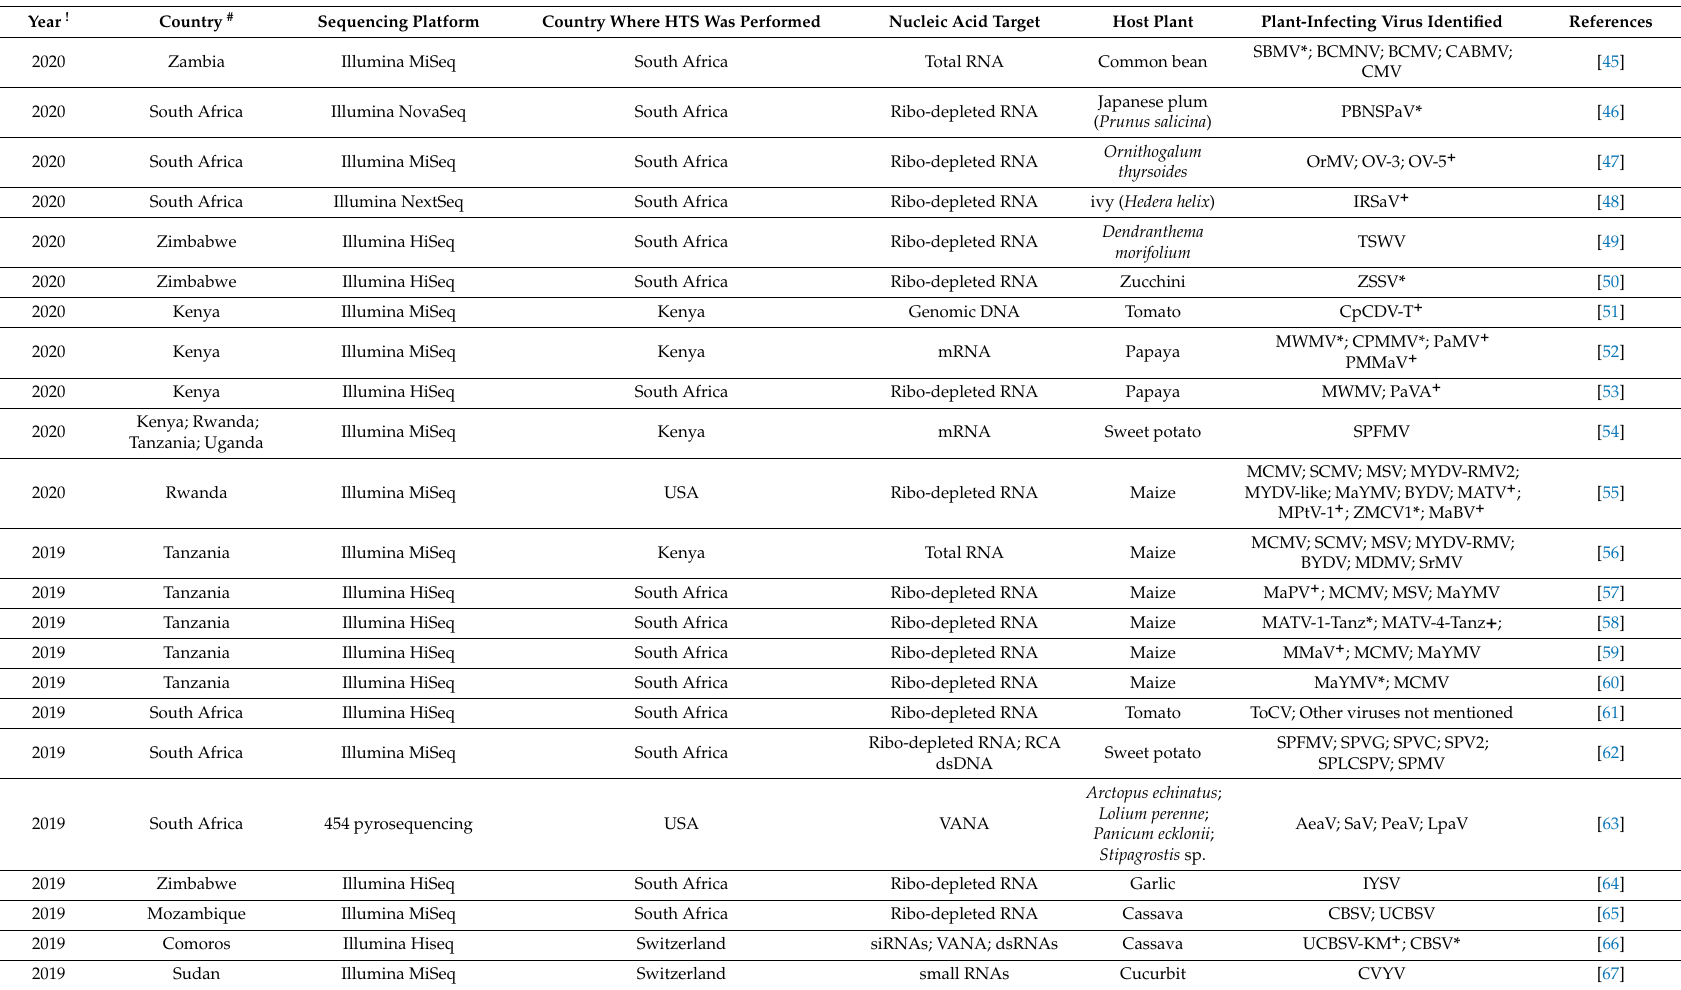
Table 2. Summary of published HTS studies conducted in African countries in relations to the detection and diagnosis of plant-infecting